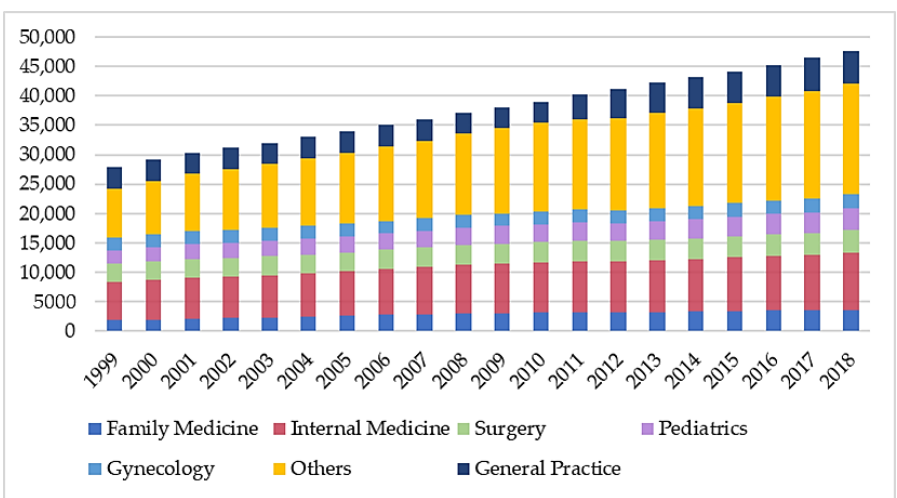
Figure 2. Number of physicians registered in different specialties in TMA in Taiwan from 1999 to 2018.